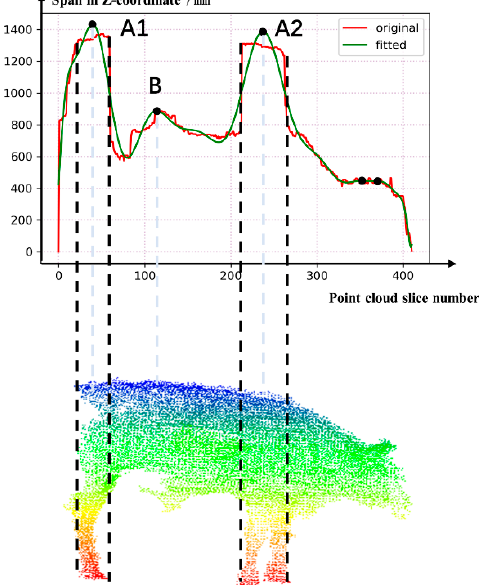
Figure 4. The distribution curve of span values for continuous slices.